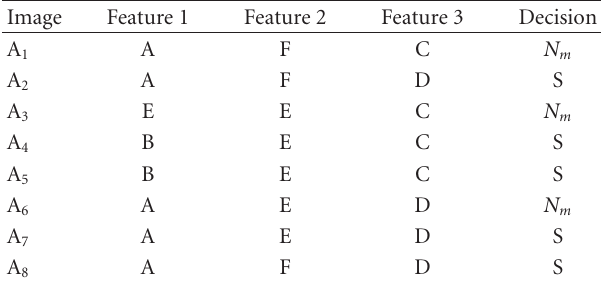
Table 1: Selected features for eight